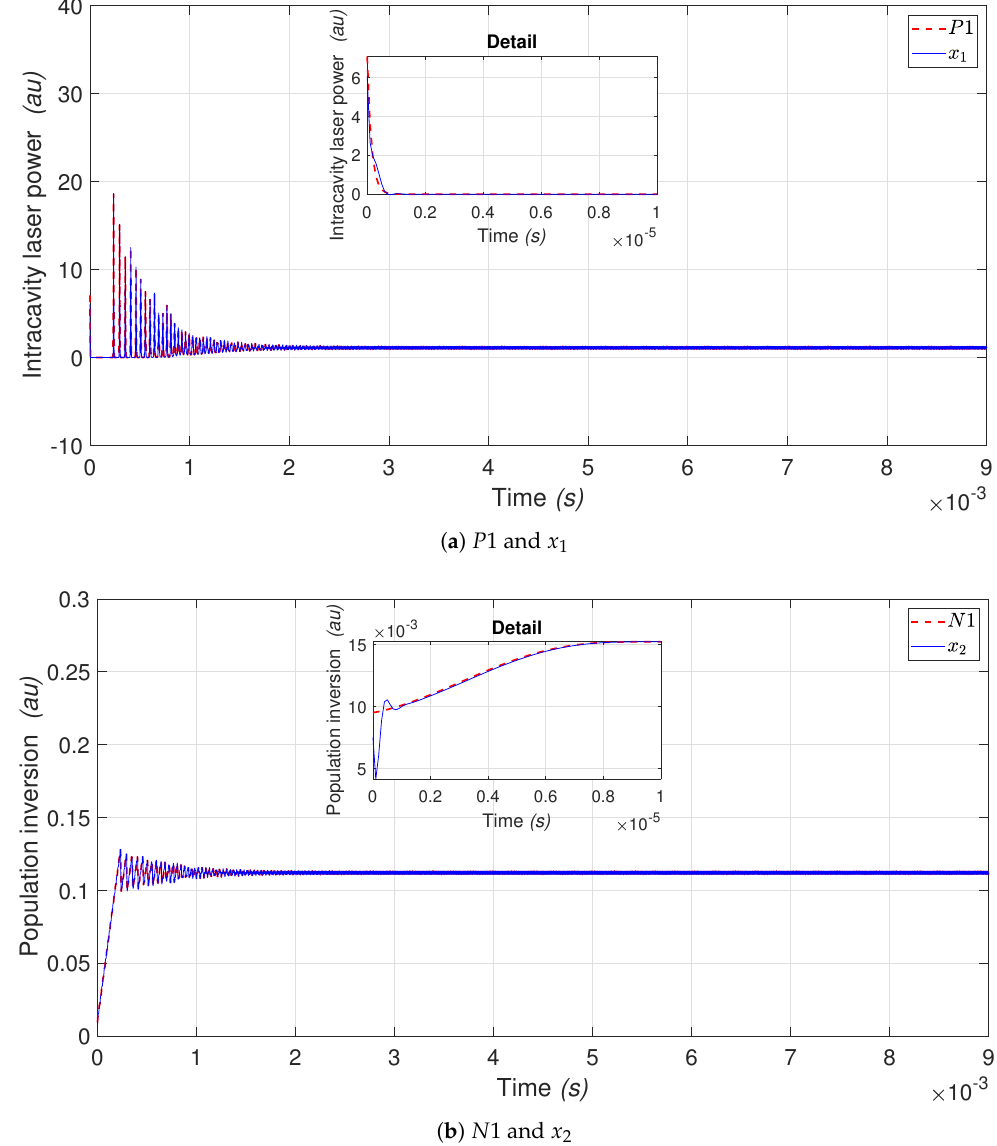
Figure 4. ( a ) Intracavity laser power P 1 and neural identification x 1 behavior. ( b ) Population inversion N 1 and neural identification x 2